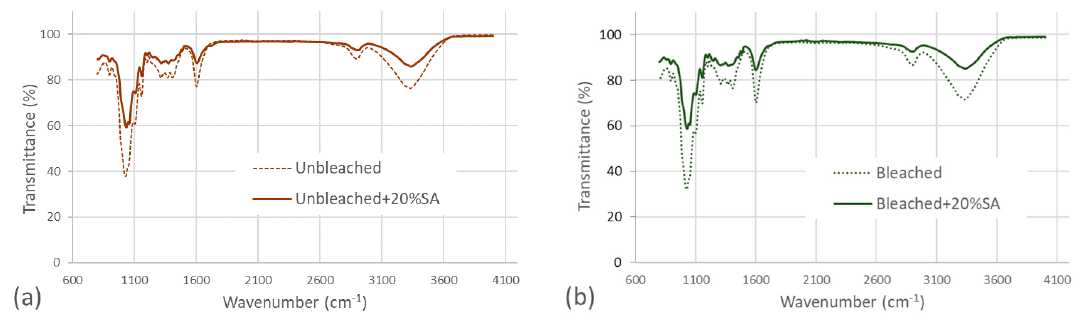
Figure 5. FTIR spectra of unbleached samples ( a ) and bleached samples ( b ).